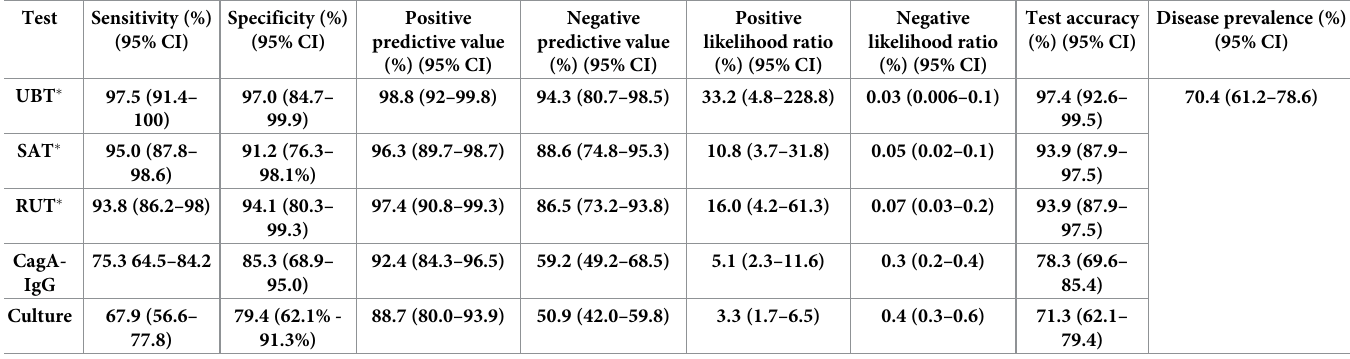
Table 4. Test performance for each Helicobacter pylori diagnostic test compared to